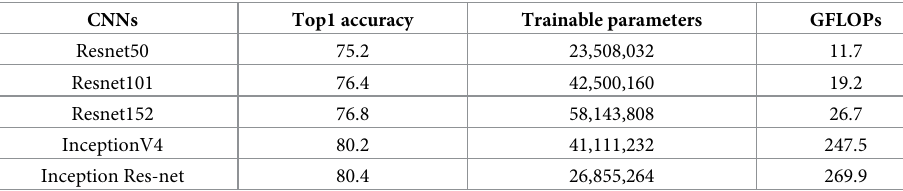
Table 3. Tested CNN network